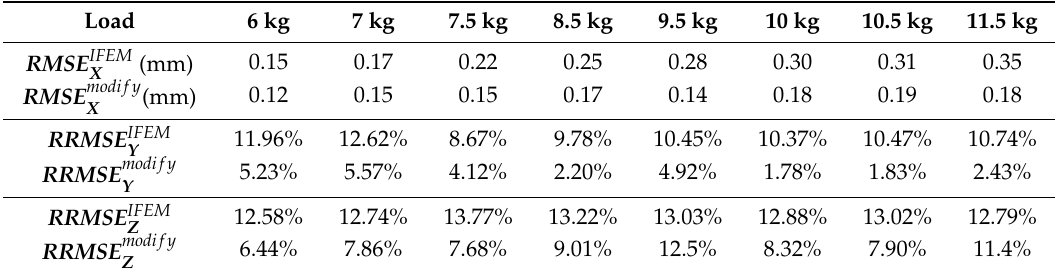
Table 4. Errors in the x, y, and z directions under di ff erent loads in the first element.